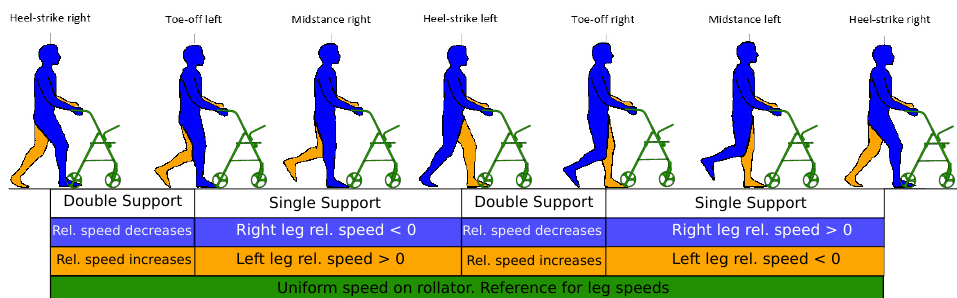
Figure 1. Leg support phases (single and double support) and velocities relative to moving rollator during gait cycle (Horizontal axis is not to